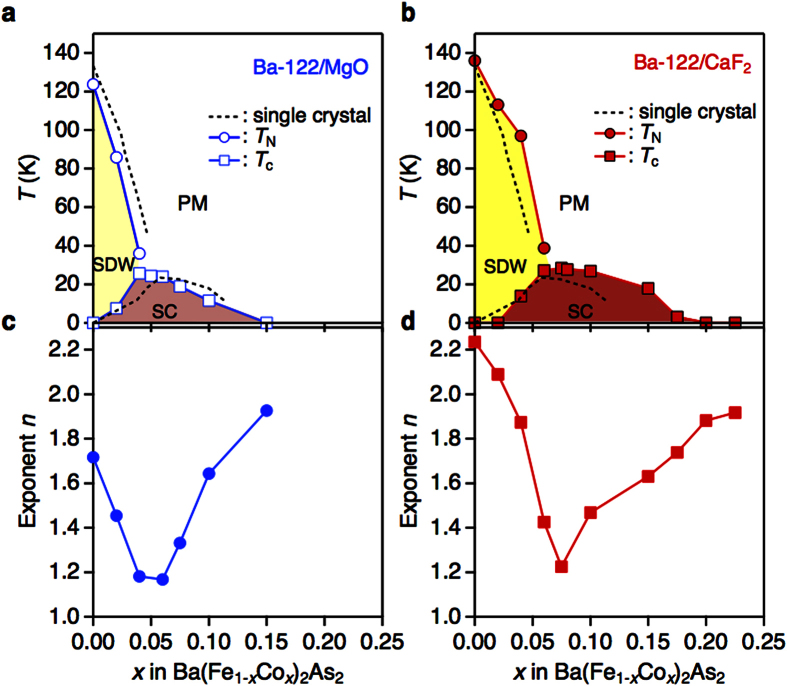
Electronic phase diagram of Ba(Fe1−xCox)2As2.The electronic phase diagram of thin films grown on (a) MgO and (b) CaF2 substrates. For comparison, the single crystal data626 are also shown in the figures as dotted lines. TN and Tc denote the antiferromagnetic and the superconducting transition temperatures, respectively. SDW, PM, and SC are the spin density wave, paramagnetic, and superconducting phases, respectively. Value for the exponent n taken from the resistivity data ρ = ρ0 + ATn in the paramagnetic state: (c) Ba-122/MgO and (d) Ba-122/CaF2.